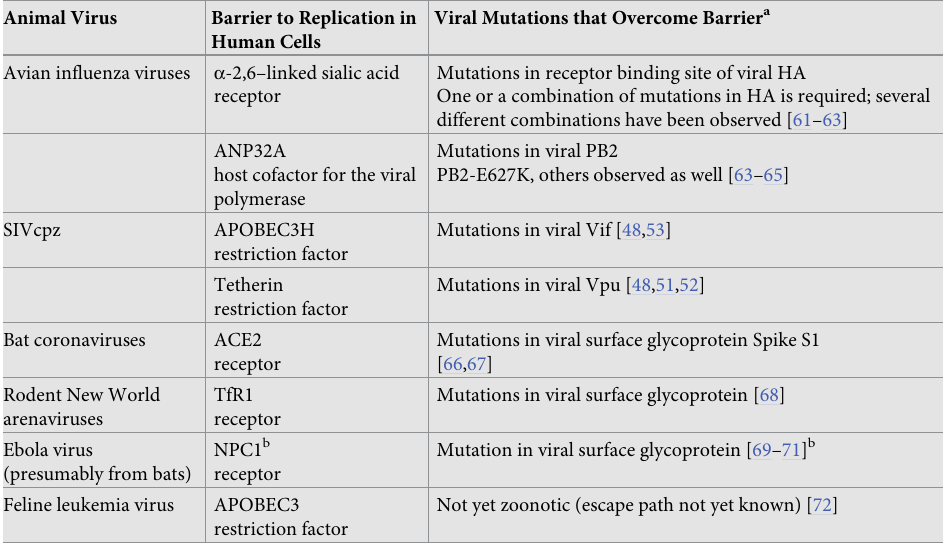
a Mutations that each virus gained to overcome these barriers in humans.